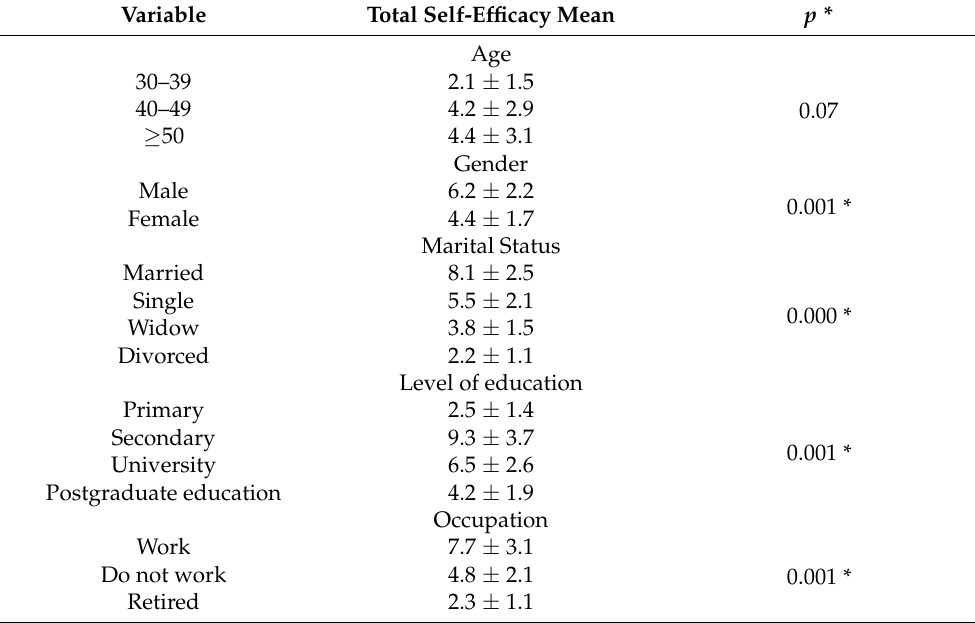
Table 5. Relationship between sociodemographic data and the total self-efficacy empowerment score (N = 60).